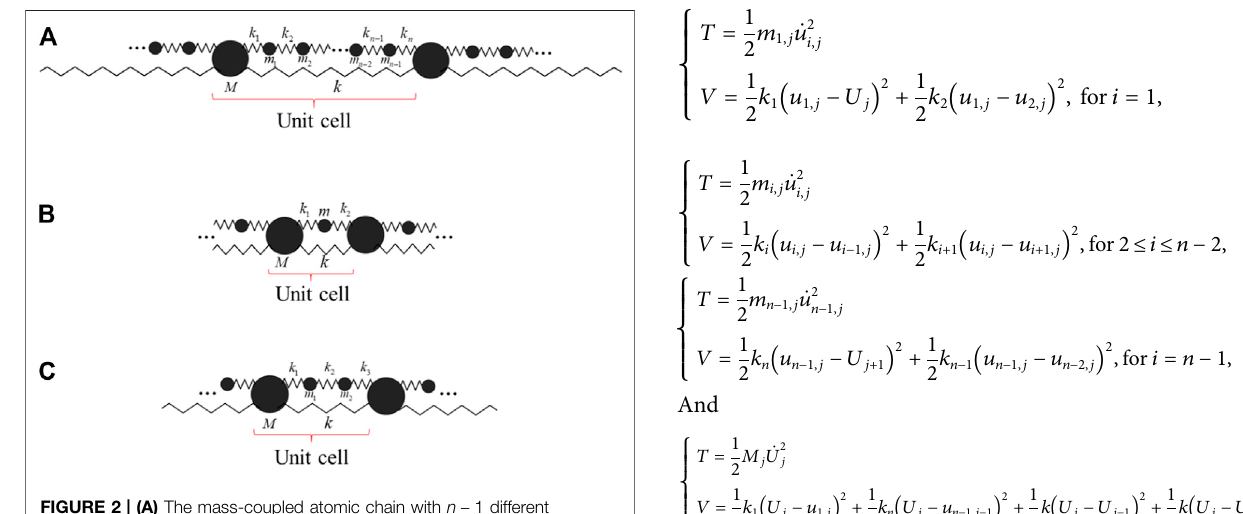
FIGURE 2 | (A) The mass-coupled atomic chain with n − 1 different masses between coupled masses in a unit cell ( n -DOF), (B) The mass- coupled monatomic/diatomic chain (2-DOF), (C) The mass-coupled monatomic/triatomic chain